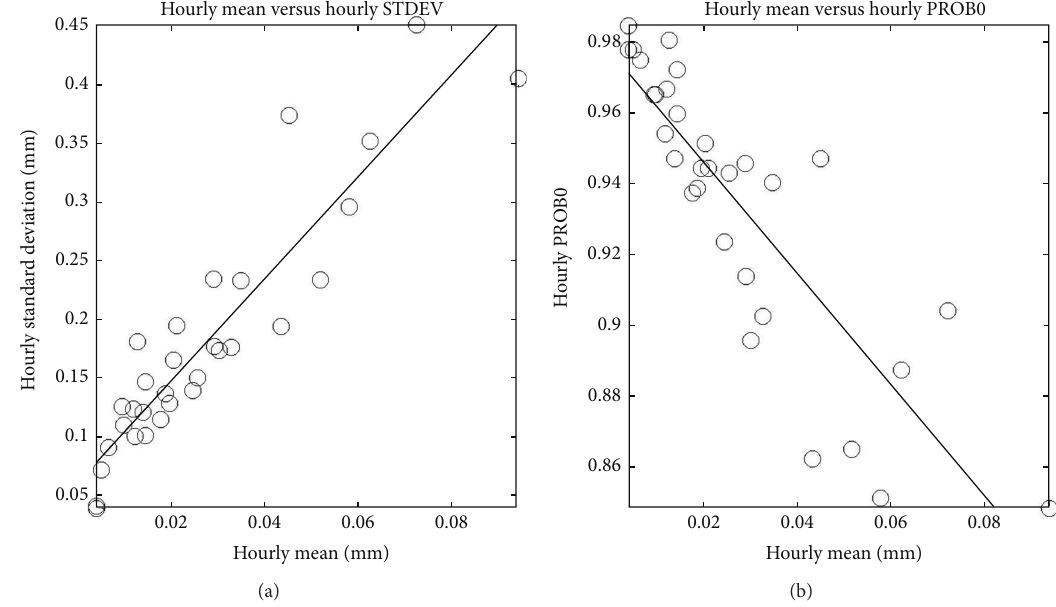
Figure 7: Relationship of MEAN1 to VAR1 (a) and PROB1 (b) and the least square regression lines at the gauge TX-4300 for the month of